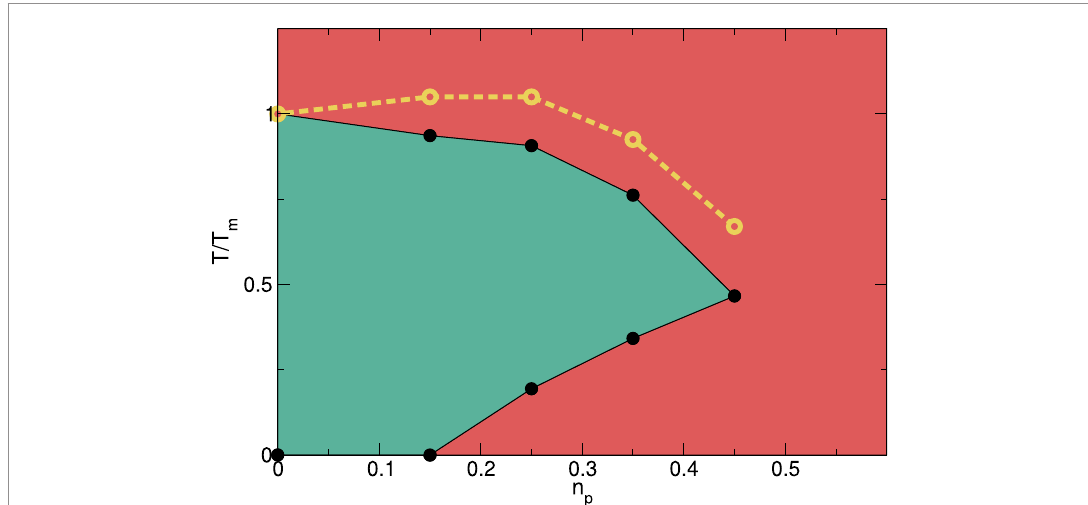
Figure 8. Phase diagram as a function of reduced temperature T / T m vs pinning density n p constructed from the features in figure 7 for a system with σ = 0.12. Green indicates the ordered regime and red indicates the disordered regime. Reentrant ordering occurs for 0 . 15 < n p < 0 . 45. The dashed line indicates the end of the peak effect window where the velocity drop is lost.